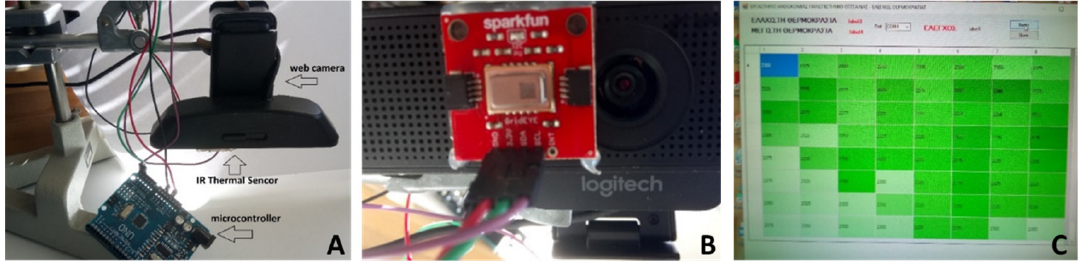
Figure 2. ( A ) The TRGB imaging system; ( B ) Thermal Camera Sensor mounted on the web camera; ( C ) 64 individual infrared temperature readings.